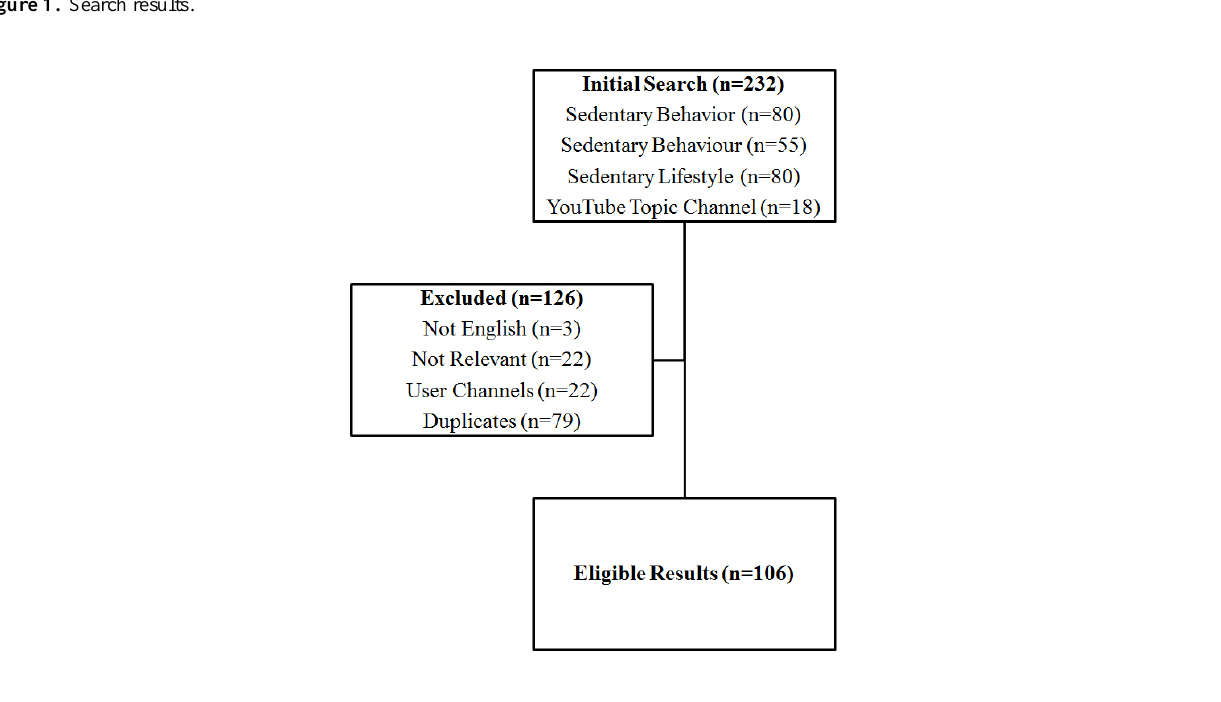
Figure 1. Search